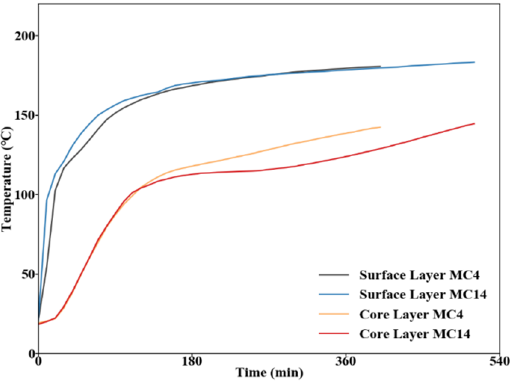
Figure 3. Temperature profiles of the Douglas fir samples during the heat treatments.